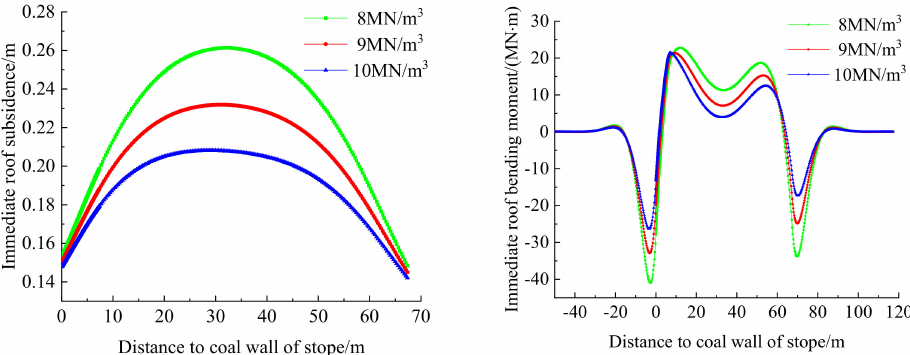
Figure 3. Relationship among elastic foundation coefficients, roof subsidence, and bending